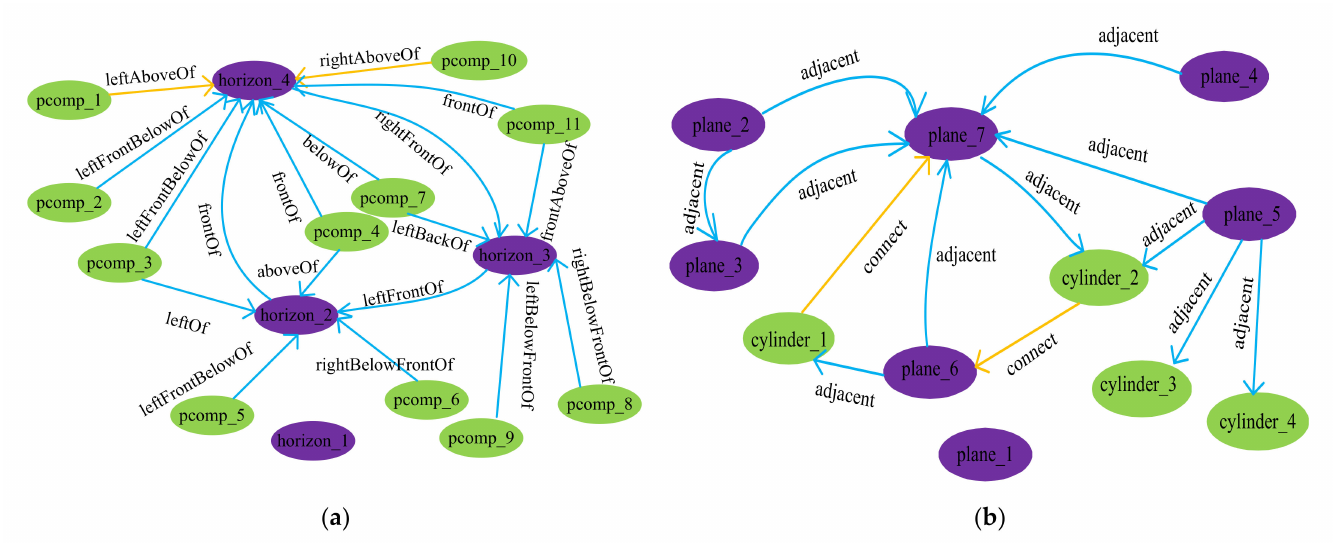
Figure 16. Spatial relationships predicts: ( a ) SGSR of the meeting room of Figure 15f; ( b ) Spatial relationships predicted on the base of the baseline